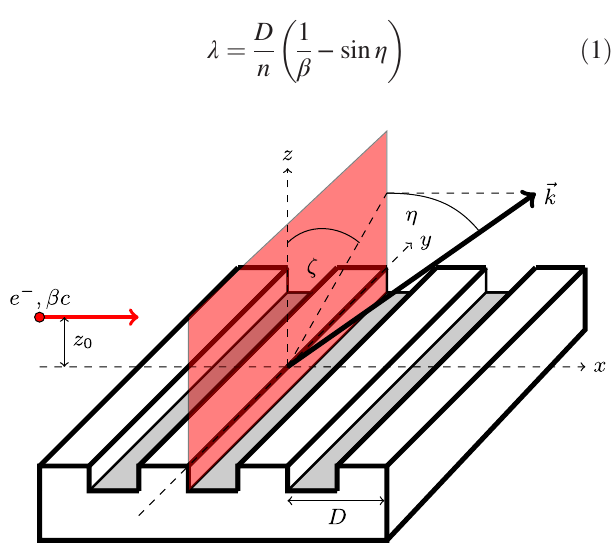
FIG. 1. Arrangement to produce SPR with corresponding ⃗ k coordinates and angles. is the vector where SPR is